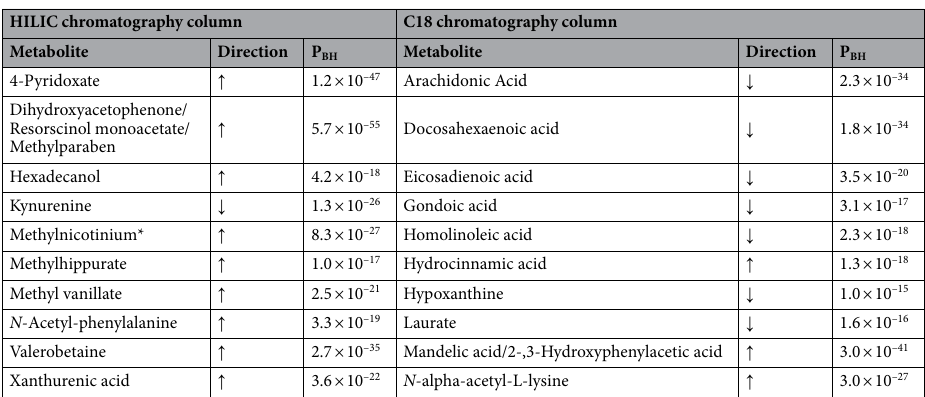
Table 2. Top ten confirmed metabolites detected by HILIC and C18 chromatography columns that were most significantly associated with infant age, based on the results of linear mixed effects models with random intercepts for individual to account for repeated measures. Results from these models were adjusted using the Benjamini–Hochberg (BH) procedure. Overall, there were 87 metabolites significantly associated with infant age in days after adjustment for multiple testing in the HILIC chromatography column and 77 in the C18 chromatography column. *This compound was unidentified but is an accurate mass match for